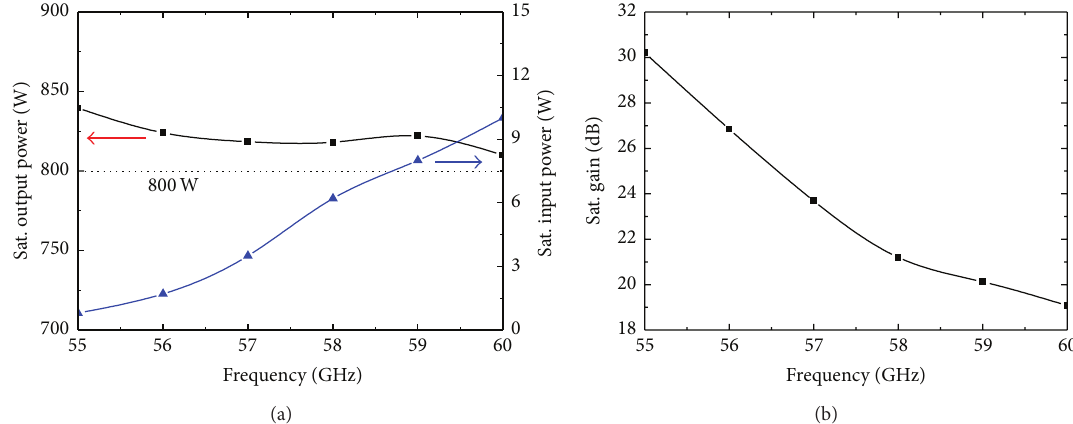
Figure 11: (a) Saturated output power and input power and (b) saturated gain of the FWG TWT ranging from 55 GHz to 60GHz.